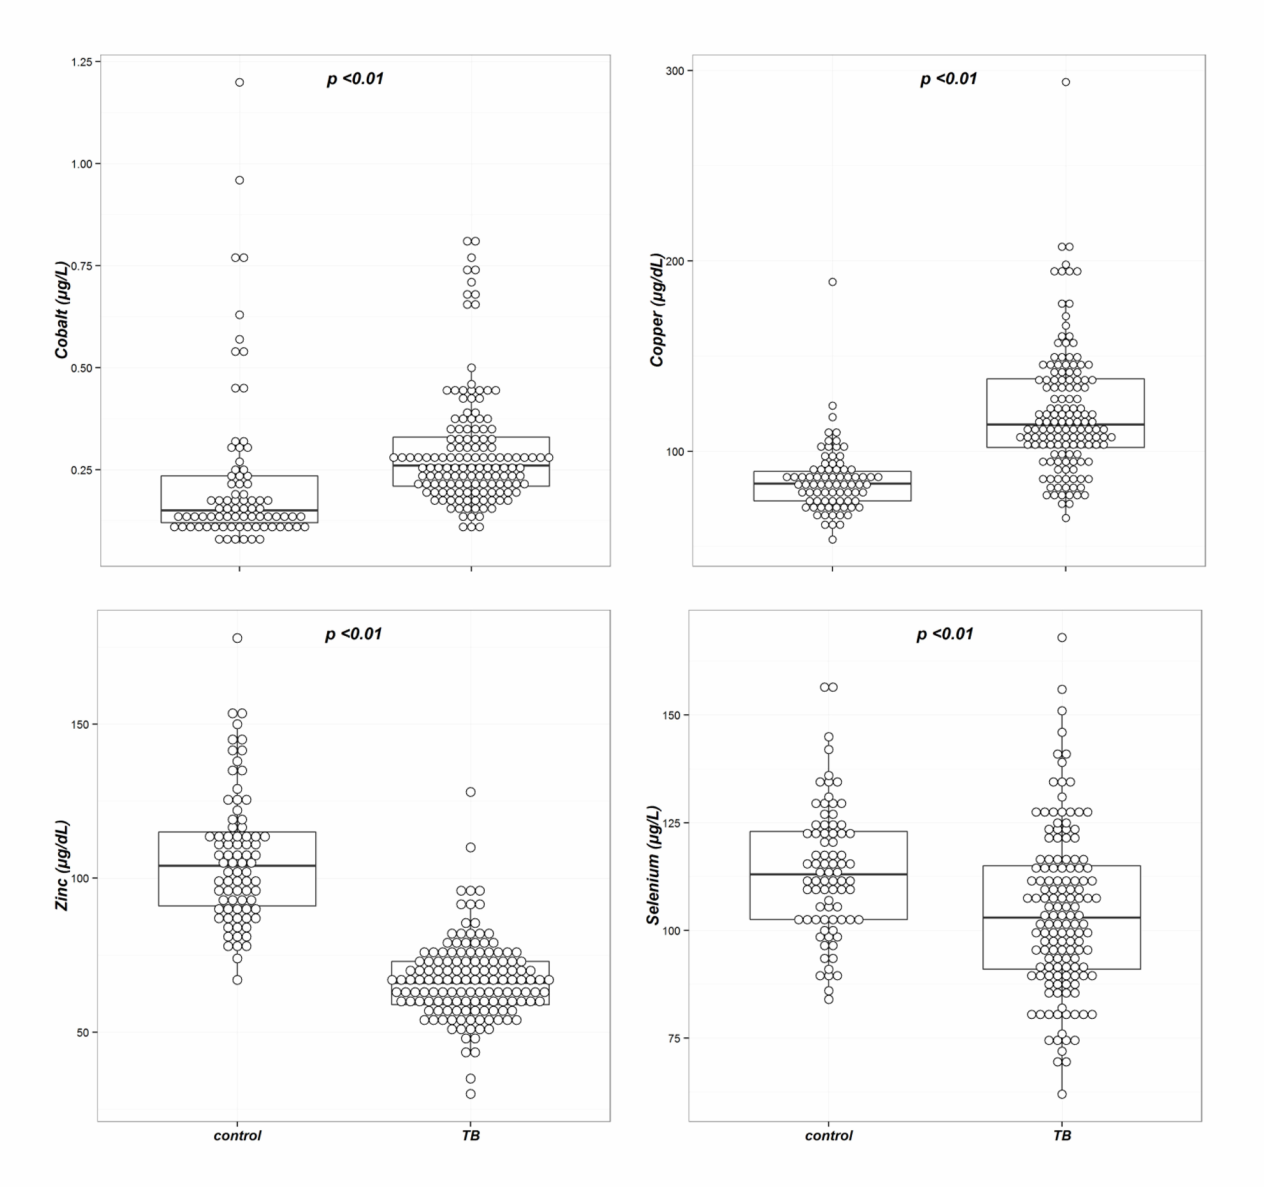
Figure 1. Box plots of the trace element concentrations in the tuberculosis and control groups. The concentrations of all four trace elements were significantly different between the two